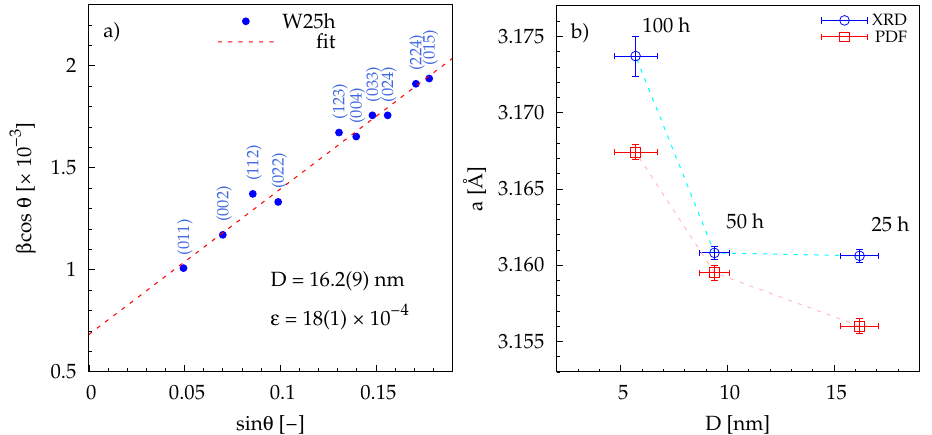
Figure 2. ( a ) Williamson–Hall plot for series of Bragg reflections belonging to the bcc-W phase in CoFeWB alloy after 25h of mechanical alloying. The mean value of crystallite size D and microstrain ε were determined from the intercept of the regression line with y -axis and its slope, respectively. ( b ) Evolution of the mean crystallite size D and lattice parameter a of the bcc-W phase in CoFeWB alloy with milling time as determined by XRD and PDF (only lattice parameter) in reciprocal and real space, respectively. Dashed lines are guides for the